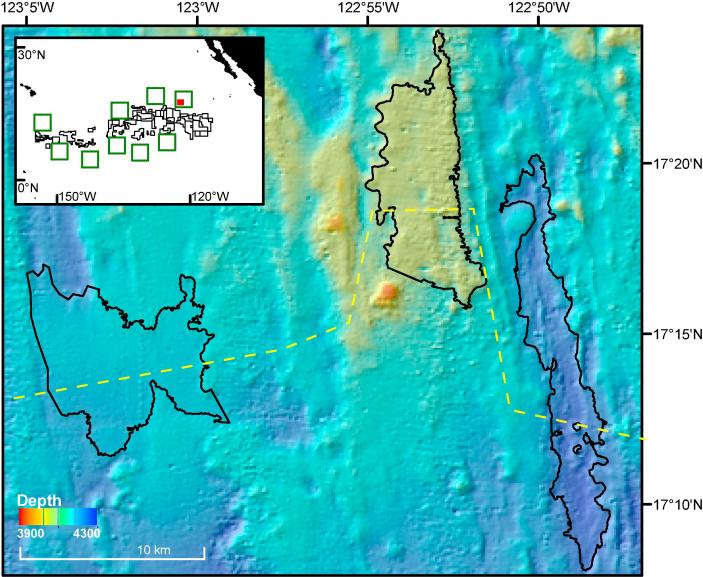
Bathymetric survey chart of the study location within the APEI6 of the CCZ (North Pacific Ocean). Depth (in metres) is indicated by the colour bar. Landscape types mapped using objective classification depicted in dark lines. Yellow dashed line shows seafloor bathymetric profile depicted in Fig. 2. A map of the eastern CCZ is inset, showing exploration licensed areas (black polygons), Areas of Particular Environmental Interest (green polygons), and study location (red square). (For interpretation of the references to colour in this figure legend, the reader is referred to the web version of this article.)